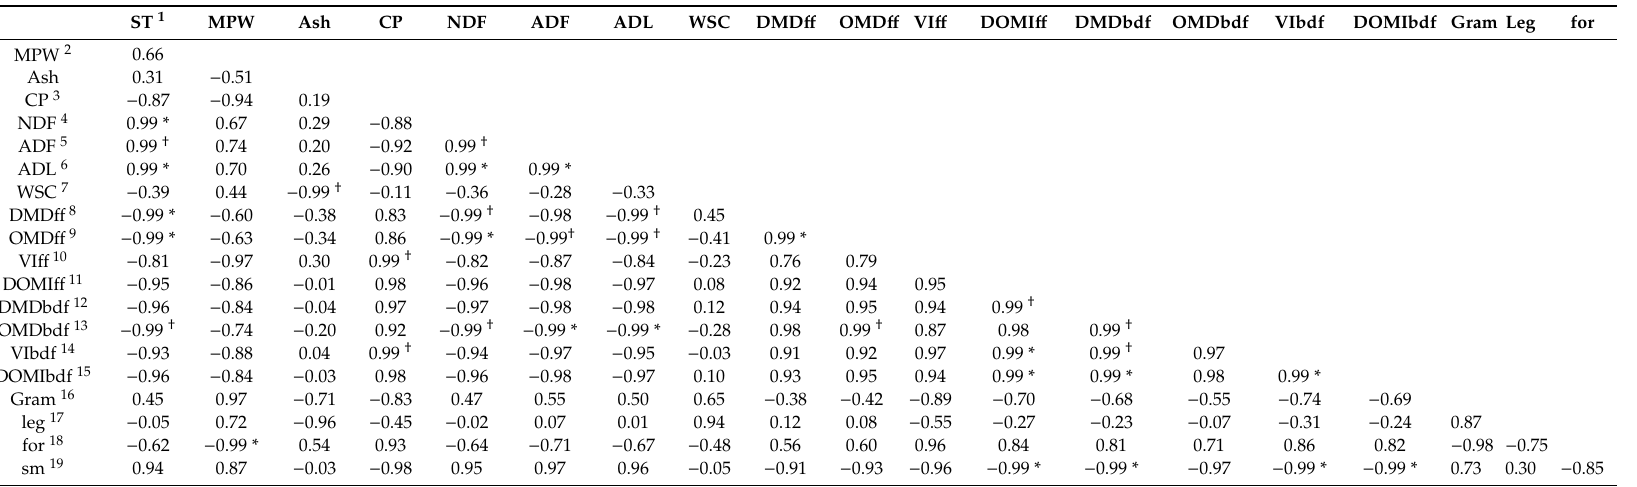
Table 5. Correlations between sum of temperatures, phenological stage, chemical composition, botanical composition, digestibility coe ffi cients, voluntary intake and digestible organic matter intake of fresh forage and barn dried forage. ST 1